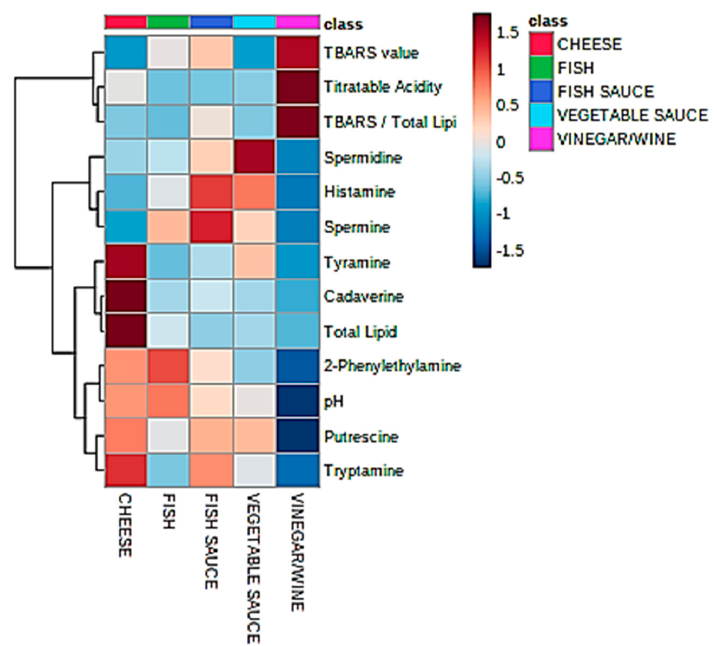
Figure 1. Heatmap diagram displaying the nature, extent and ANOVA-based significance of univariate differences between mean values of all 8 BA and further chemoanalytical food quality variables (near right-hand side y -axis) for the fermented cheese (red), fish (green), fish sauce/paste (dark blue), vegetable sauce (pale blue), and wine/vinegar (mauve) products. The complete dataset was glog-transformed and autoscaled prior to analysis, but not CS-normalized. Transformed analyte intensities are shown in the far right-hand side y -axis: deep blue and red colorations represent extremes of low and high contents respectively. The left-hand side of the plot shows results arising from an associated agglomerative hierarchical clustering (AHC) analysis of these variables, which reveals two major analyte clusterings, with three sub-clusterings for one of these. The top right-hand side major cluster comprises TBARS level, (TBARS):(total lipid) ratio and TA value, whereas the second contains all other analyte variables, including all BA contents. The first, second, and third sub-clusters within the bottom right-hand side major cluster feature spermine, spermidine, and histamine (the first two of these arising from the same putrescine and metabolically upstream ornithine and agmatine/arginine sources respectively); tyramine, cadaverine, and total lipid; and 2- phenylethylamine, putrescine, tryptamine, and pH respectively. Prior to the performance of MV statistical analysis of the dataset acquired, simple Pearson correlations were explored between all explanatory variables considered, and Figure 2 shows a correlation heatmap for these relationships. Clearly, there were moderate to strong positive correlations observed between all fermented food BAs present, the strongest observed between 2- phenylethylamine and tyramine (both aromatic BAs), tryptamine and spermine, and most notably, between cadaverine and histamine. Food pH values were found to have the strongest positive correlations with tyramine > putrescine > tryptamine, although spermidine was predominantly uncorrelated with this index. Moreover, as anticipated, TA was strongly negatively correlated with pH value > putrescine > tyramine ≈ histamine contents in that order. TBARS level, however, was largely independent of all BAs and their concentrations, with the exception of spermidine, which exhibited a weak positive relationship with this variable. Similarly, total lipid level was also mainly uncorrelated with all BA contents but was quite strongly anti-correlated with (TBARS):(total lipid) ratio and non-lipid-normalized TBARS value (both expected). The (TBARS):(total lipid) ratio was either strongly or moderately anti-correlated with all BA levels, and this may provide an indication